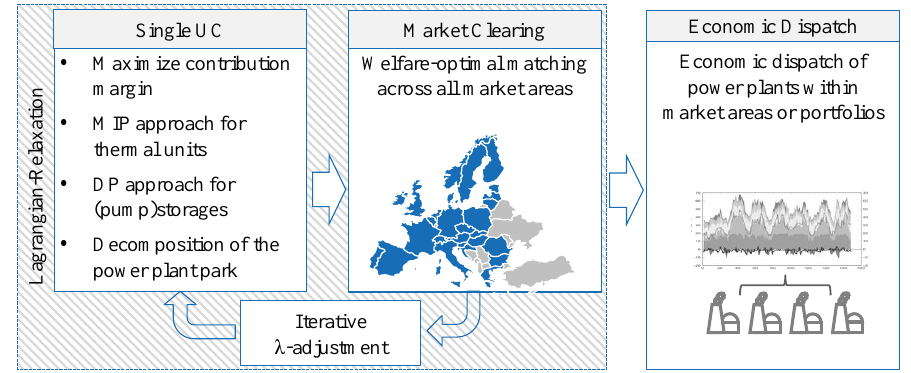
Figure 5. Overview of the full model decomposed using Lagrangian